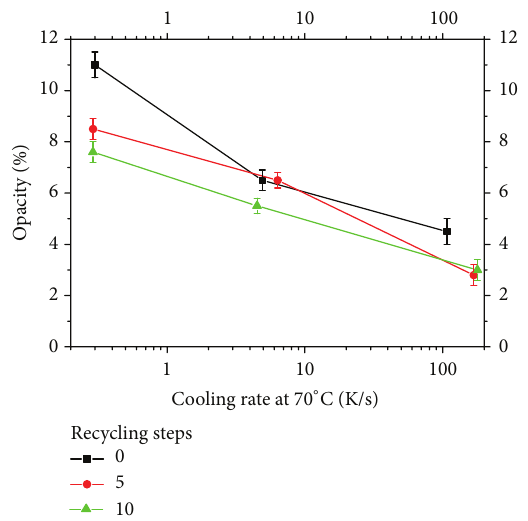
Figure 1: Effect of cooling rates and recycling steps on the opacity of the films.